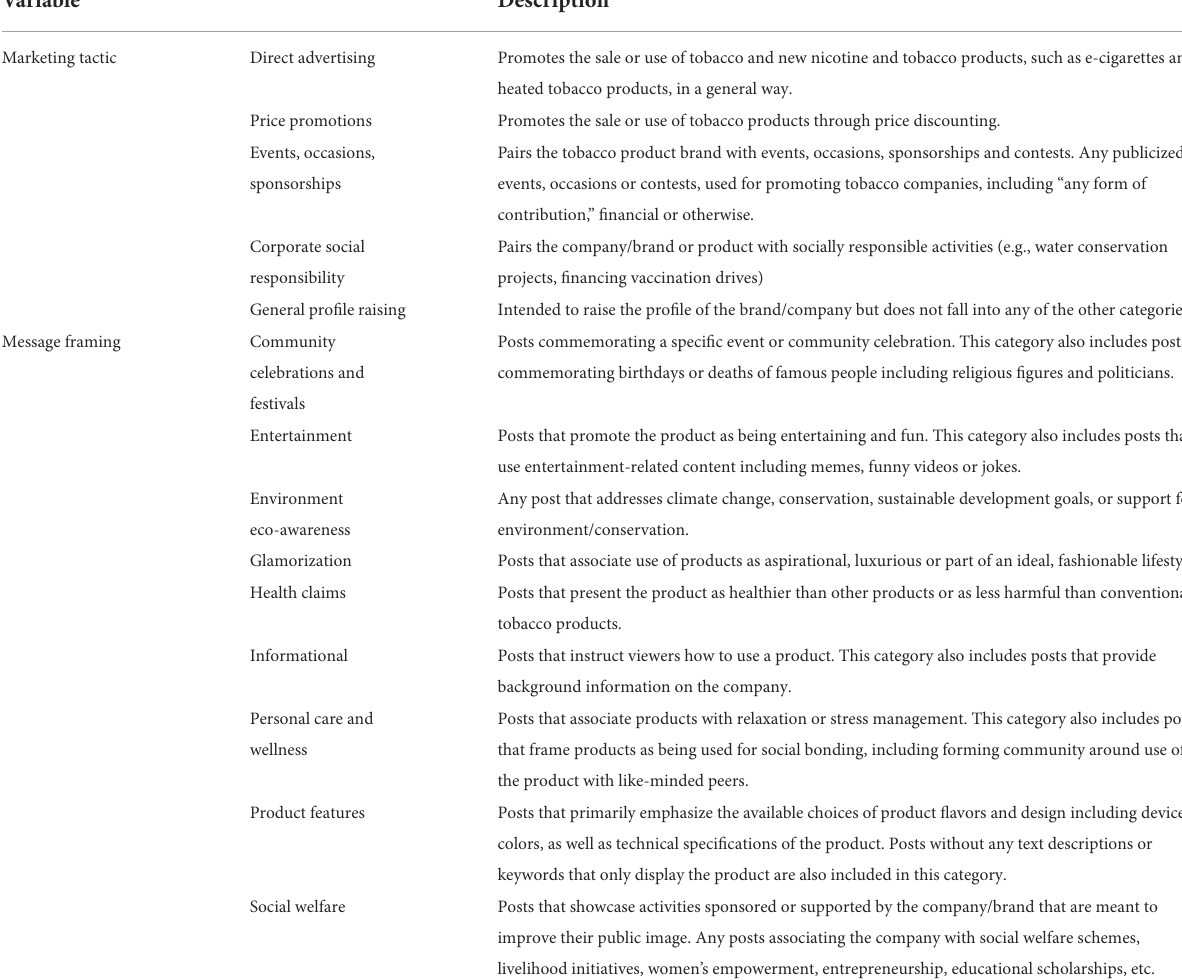
TABLE 1 Definition of marketing tactics and message framing used in the analysis for this